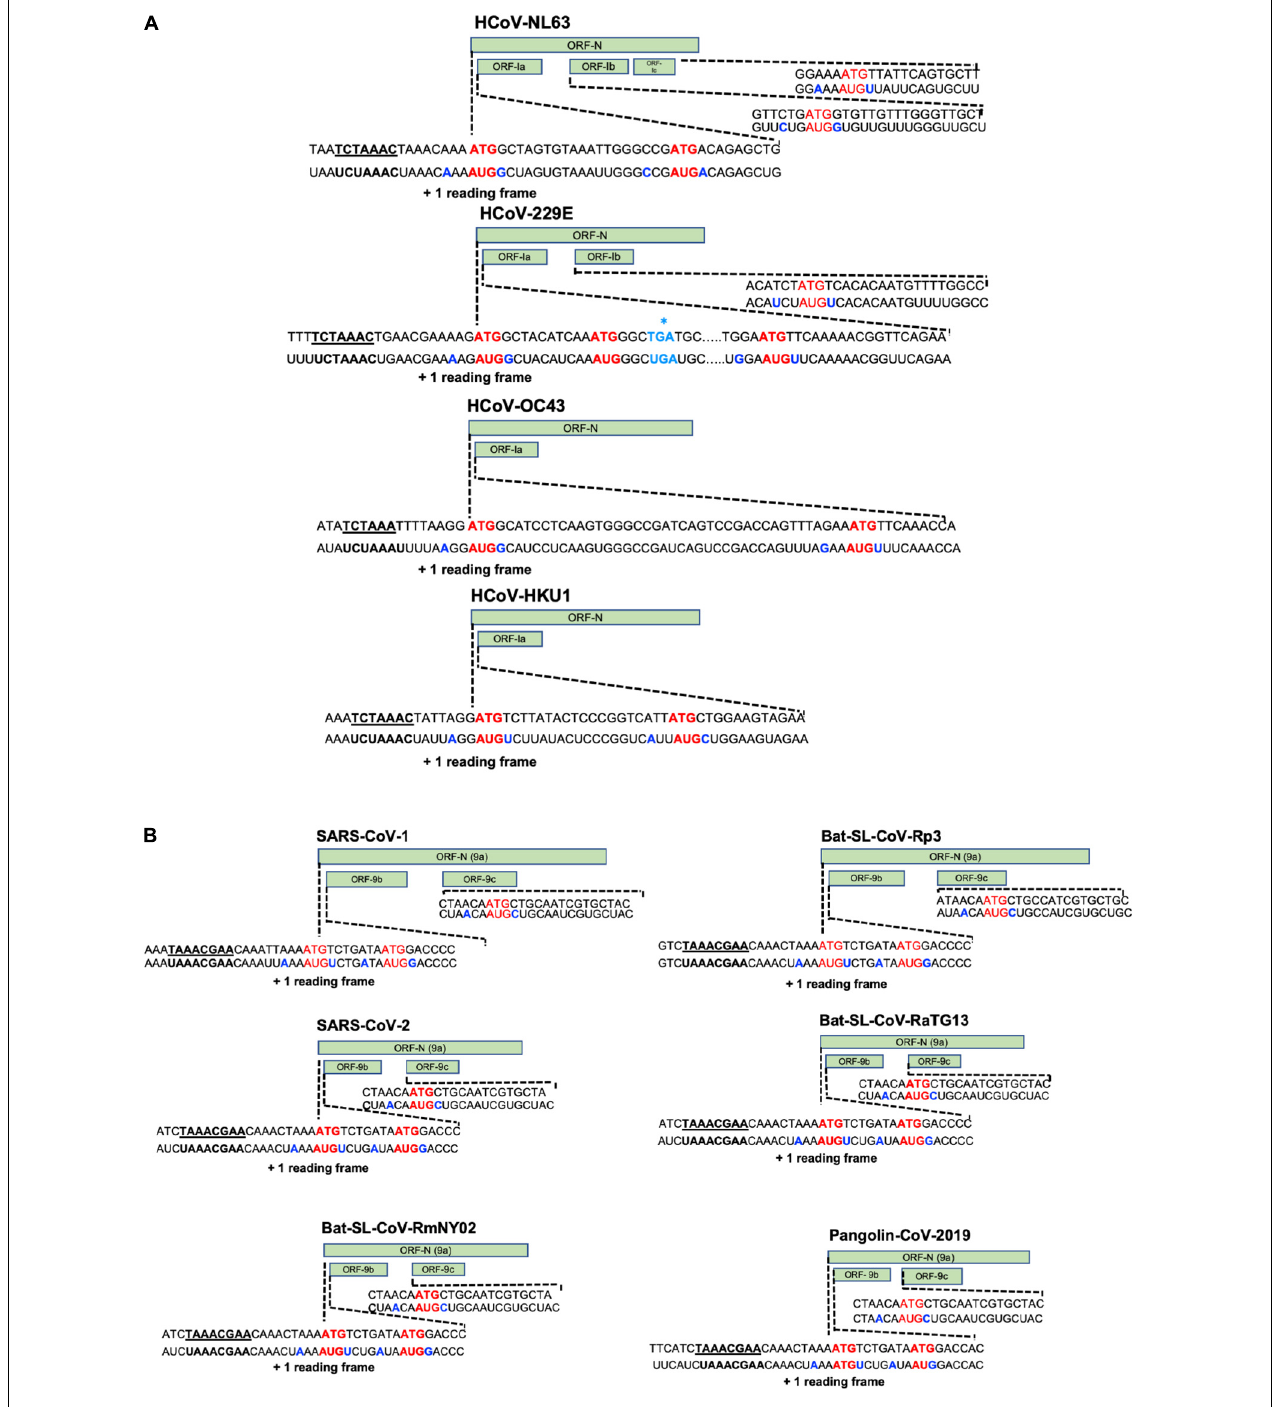
FIGURE 5 | Expression of the ORF accessory genes embedded in the N gene. (A) AlphaCoV. HCoV-NL63 (AY567487), the initiation of the ORFN represented an optimal Kozak context (A at –3, G at +4). The initiation of the ORFIa indicated a suboptimal Kozak context (C at –3, A at +4). The initiation of the ORFIb represented a suboptimal Kozak context (C at –3, G at +4) (281). The initiation of the ORFIc indicated a suboptimal Kozak context (A at –3, U at +4). HCoV-229E (AF304460), the initiation of the ORFN represented an optimal Kozak context (A at –3, G at +4). The initiation of the ORFIa indicated a suboptimal Kozak context (G at –3, U at +4). Even if a start codon is presented at the same site as the start codon of ORF9b of SARS-CoV-1 or SARS-CoV-2, a stop codon (asterisk) is found on the third codon following the start codon. The initiation of the ORFIb represented a suboptimal Kozak context (U at –3, U at +4). BetaCoVs. HCoV-OC43 (AY903460), the initiation of the ORFN represented an optimal Kozak context (A at –3, G at +4). The initiation of the ORFI indicated a suboptimal Kozak context (A at –3, U at +4). HCoV-HKU1